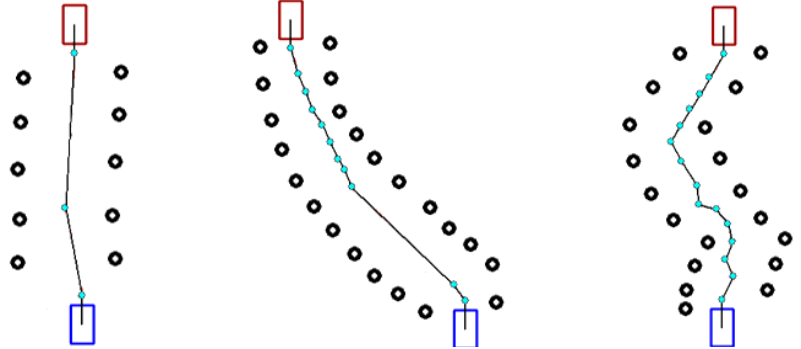
Figure 11. Results of path planning by RBF.